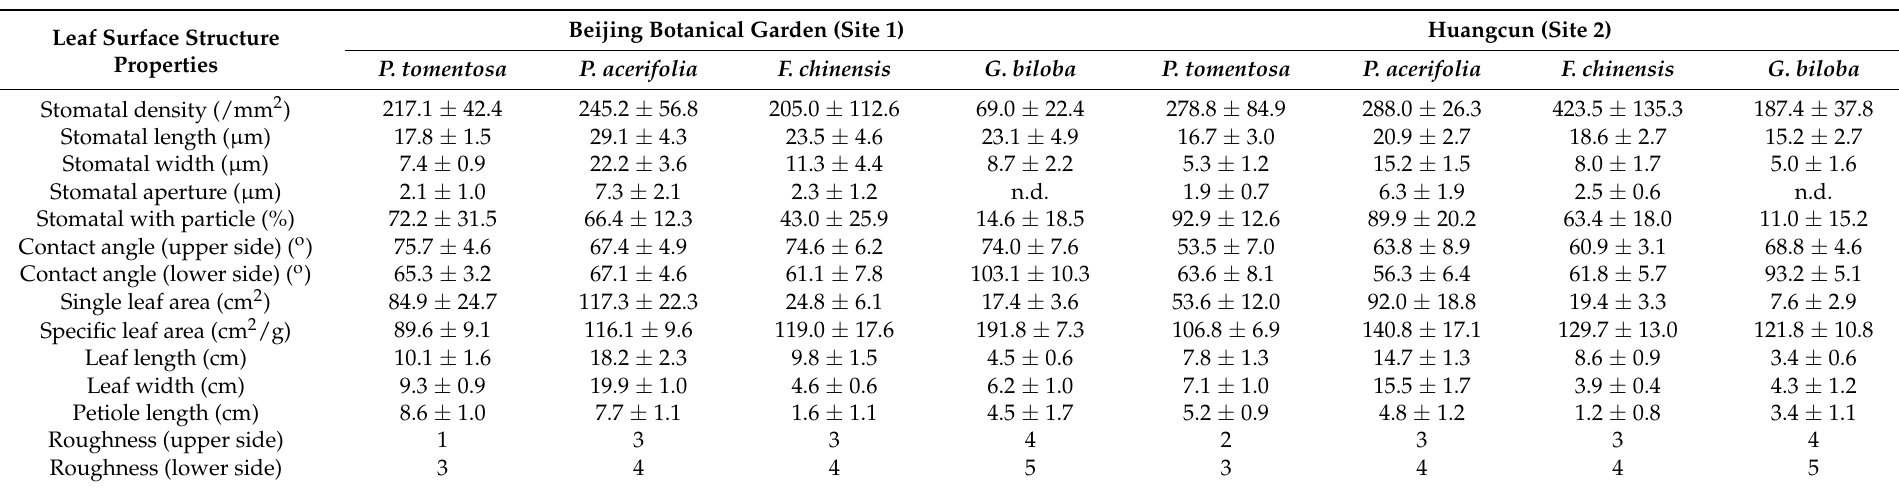
Table 2. Means ( ± SD) of leaf surface structural properties in the Beijing Botanical Garden (Site 1) and Huangcun (Site